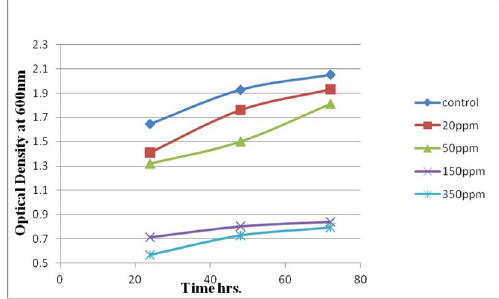
) using Fig. 7. Growth curve of isolate A2 with (PbNO 2 different concentrations.